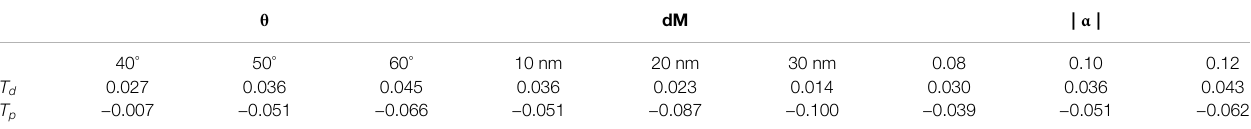
TABLE 1 | Difference between the α > 0 and α < 0 at the transmission peak and transmission dip of the Fano-type